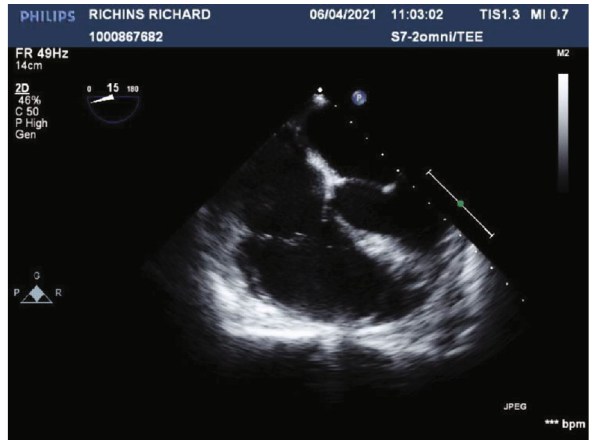
Figure 2: Transesophageal echocardiogram results.